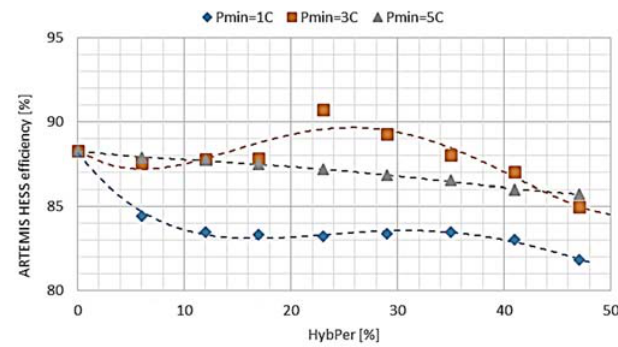
Figure 4. HESS global efficiency for topology 2 as a function of the hybridization percentage for three different values of P MIN .